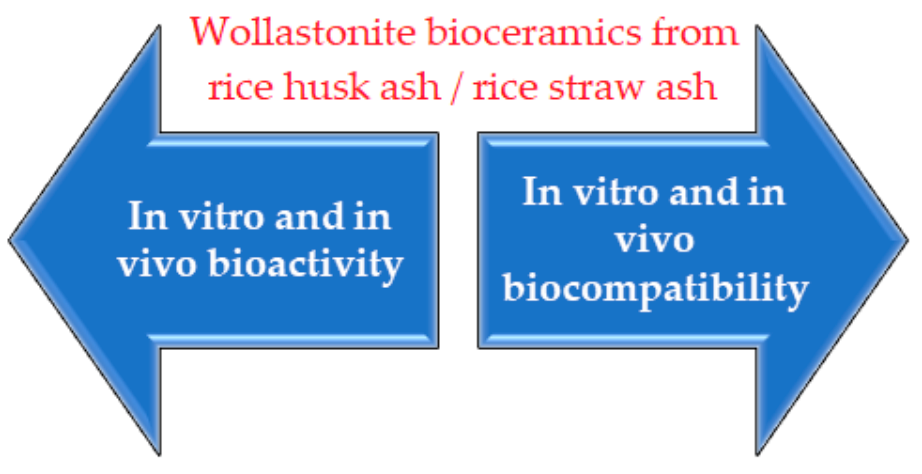
Figure 1. The core outline of this review.